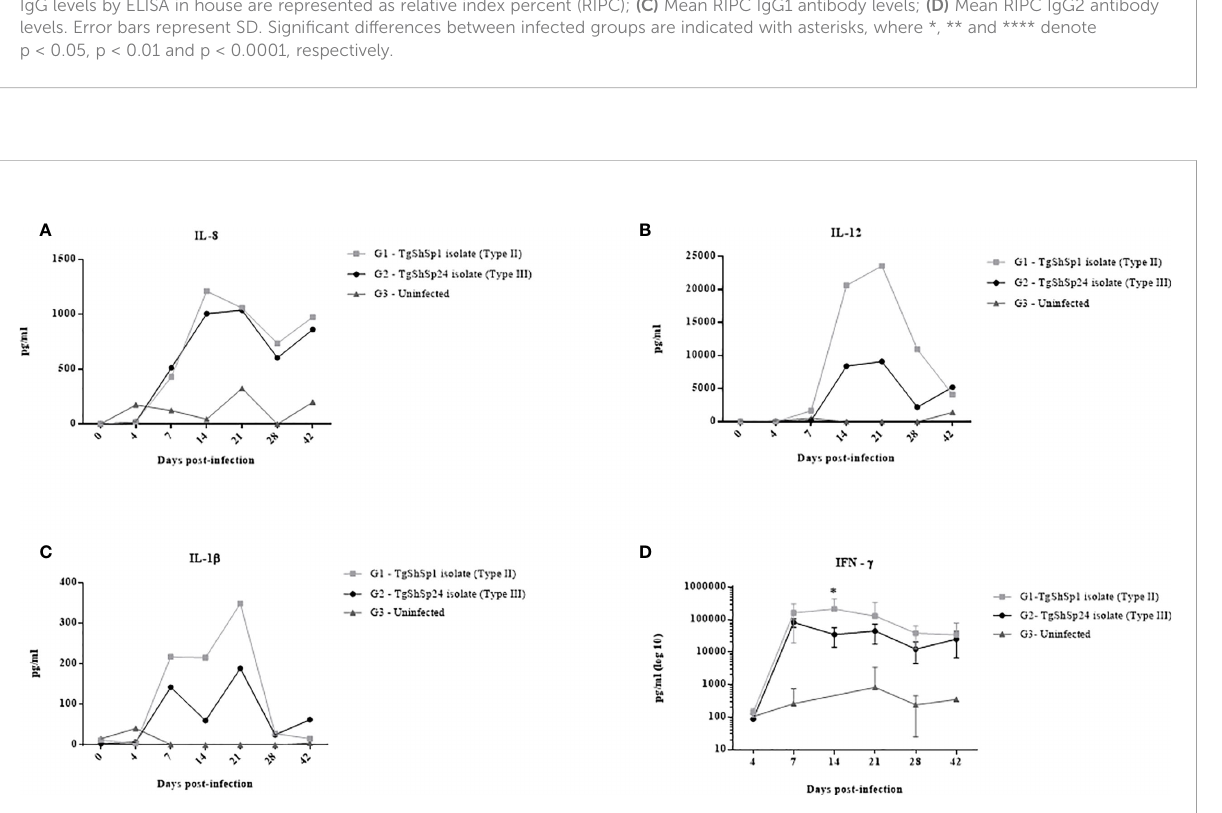
FIGURE 5 Cytokine levels measured in cell-free culture supernatants after speci fi c T. gondii stimulation: IL-8 (A) , IL-12 (B) and IL-1 b (C) . Each point represents the concentration of cytokines in the pooled supernatants for groups infected with TgShSp1 (G1), infected with TgShSp24 (G2) and uninfected control (G3) throughout the study. (D) IFN- ɤ responses measured in cell-free culture supernatants from individual animals of the G1, G2 and G3 groups. Each point represents the mean at the different sampling times for each group. Error bars represent SD. Signi fi cant differences between infected groups (*) indicate p <